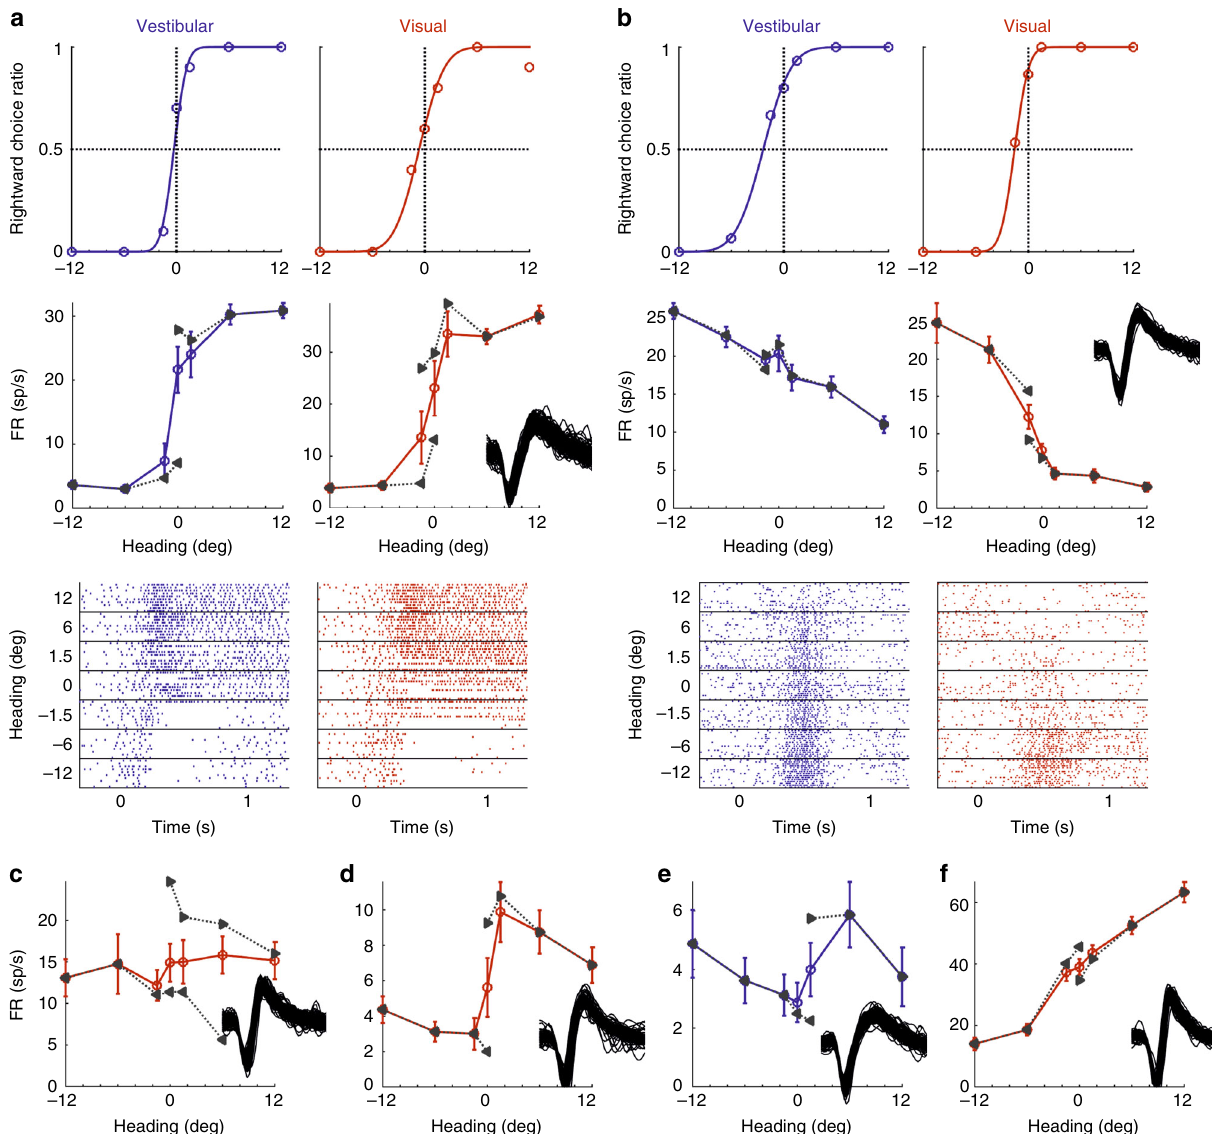
Fig. 1 Example single-unit recordings from awake, behaving monkeys during heading discrimination. a , b The behavioral data from two example sessions, along with simultaneous single-unit recordings from VIP. Top row : psychometric curves represent the ratio of rightward choices as a function of heading, based on visual ( red ) or vestibular ( blue ) cues. The data ( circles ) were fi tted with cumulative Gaussian functions ( solid curves ). Second row : average fi ring rates (FRs) are presented as a function of heading. Leftward and rightward pointing gray triangles mark the average FRs for leftward and rightward choices, respectively. For each unit, one hundred (randomly selected) overlaid spikes are presented ( insets ). Third row : raster plots depict the spikes for each trial, as a function of time. Stimulus motion, having a Gaussian velocity pro fi le, spanned the epoch from 0 to 1 s. Horizontal black lines in the raster plots separate different headings. c – f Average FRs as a function of heading are presented for four additional VIP units (3 units tested with the visual condition in red , and 1 unit tested with the vestibular condition in blue ) from four separate sessions. All error bars denote